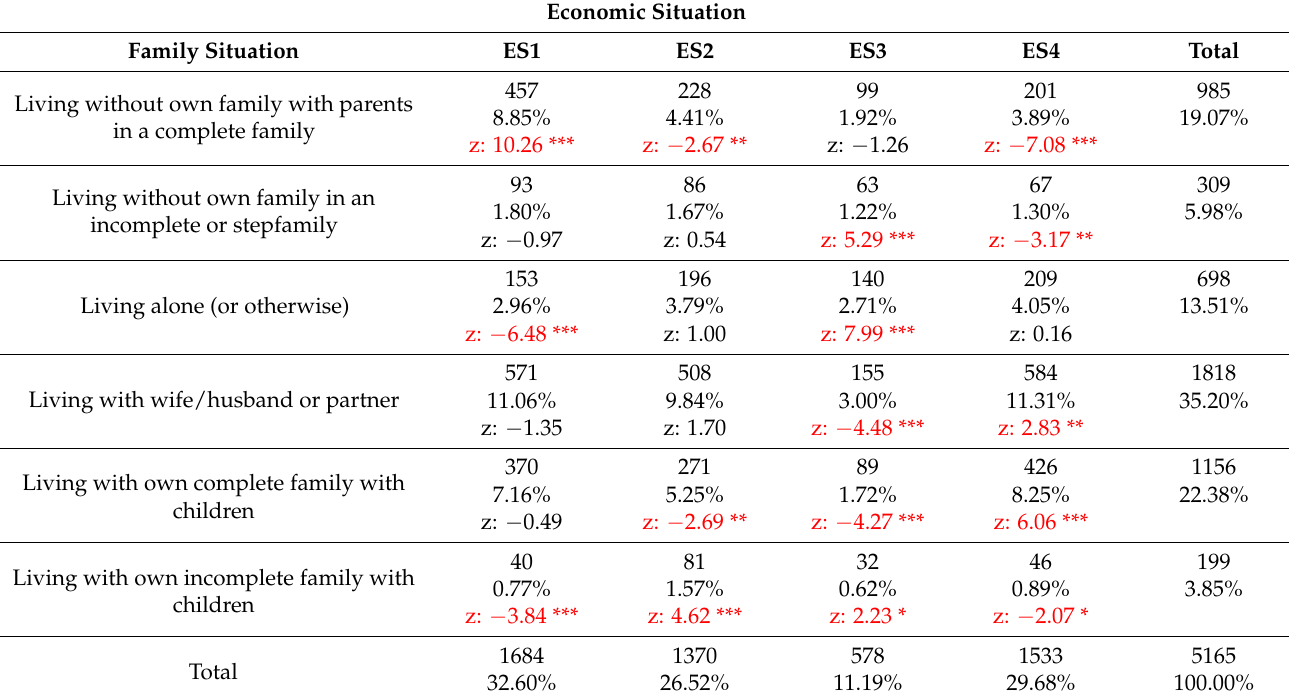
Table 6. Economic situation’s dependence on family situation.